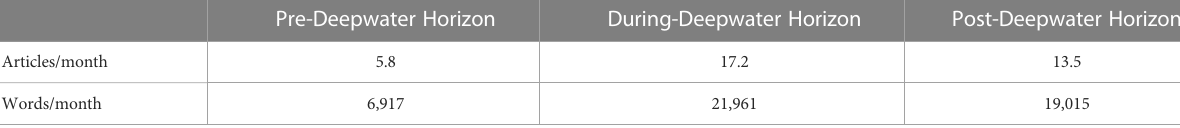
TABLE 2 Articles per month and words per month in DHORN corpus for each time span.